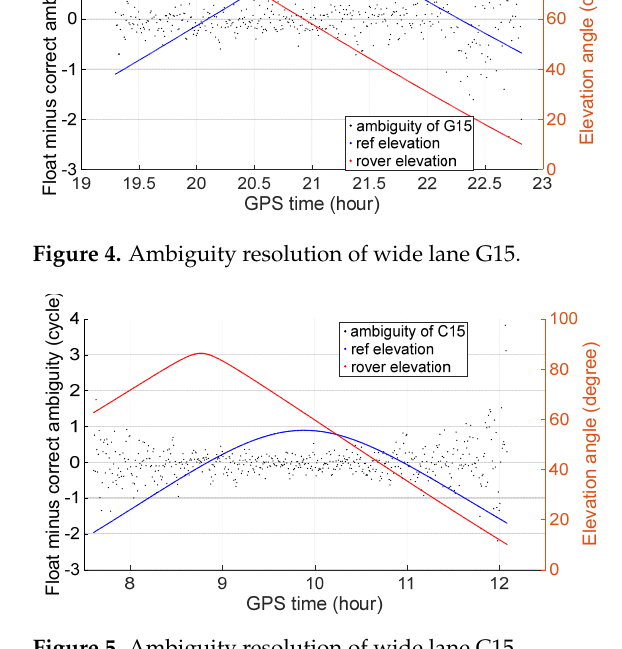
Figure 4. Ambiguity resolution of wide lane G15.